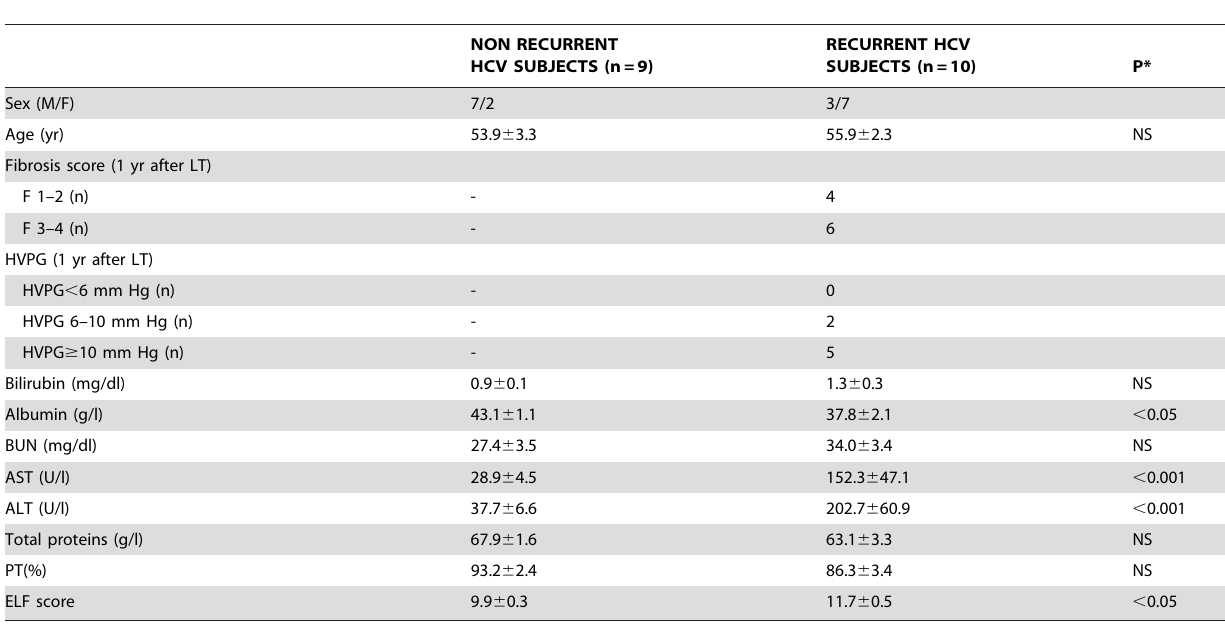
Table 1. Baseline characteristics of liver transplant recipients in non recurrent and recurrent hepatitis C patients.